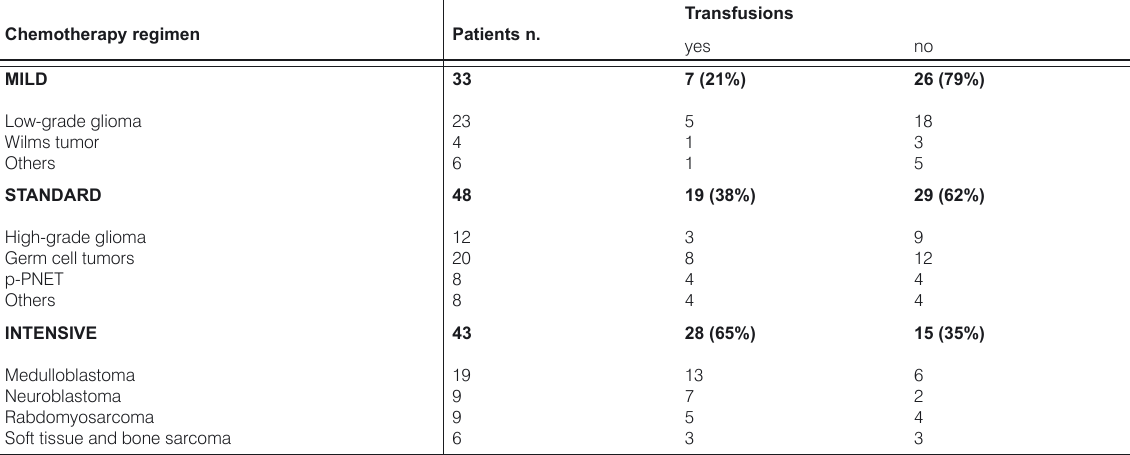
Table 5. Chemotherapy regimens and frequency of